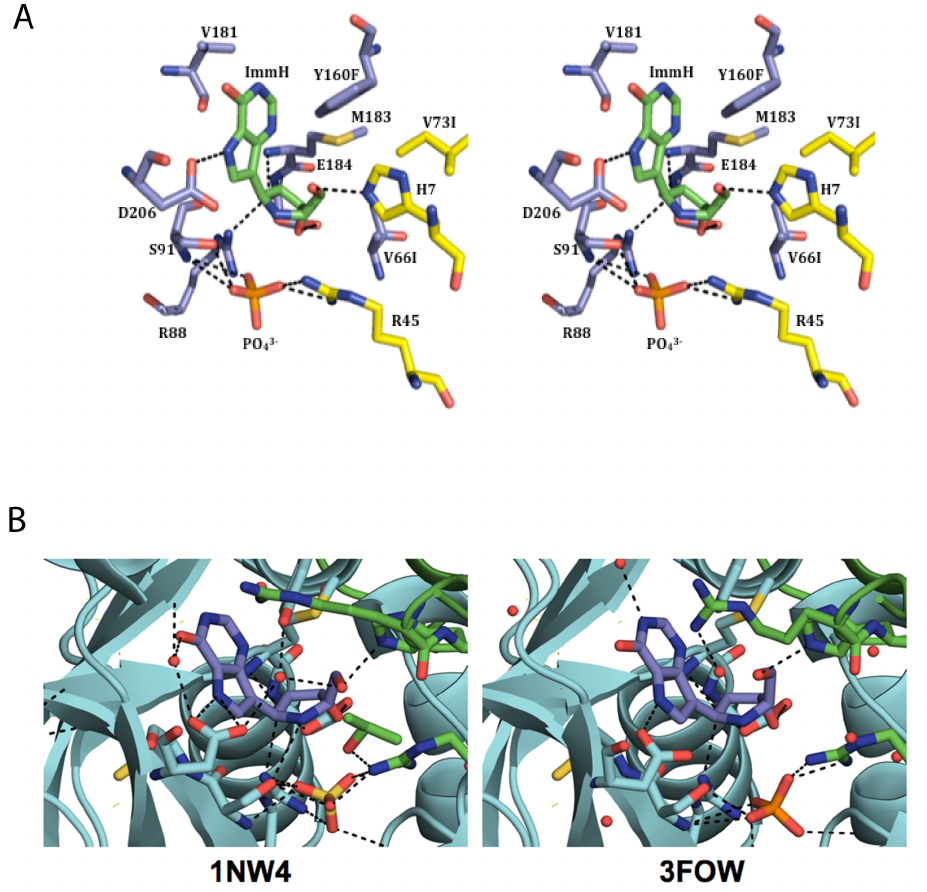
Figure 5. Structure of the V66I:V73I:Y160F PfPNP mutant with transition state inhibitor ImmH. A ) Cross-eyed stereo views of the catalytic site contacts in V66I:V73I:Y160F PfPNP with the transition state analogue inhibitor ImmH and PO 43 2 . The figure was created using MacPyMol [23]. Light blue side chains show the parental monomer surrounding the bound ImmH ( green ), while the yellow side chains indicate residues contributed from the adjacent subunit. The highlighted imino nitrogen is in blue and the 5 9 -hydroxyl oxygen is in red . B ) Side by side images of the decreased convalent interactions located in the enzymatic pocket of V66I:V73I:Y160F PfPNP mutant (3FOW) on the right with WT PfPNP (1NW4) as a comparison.